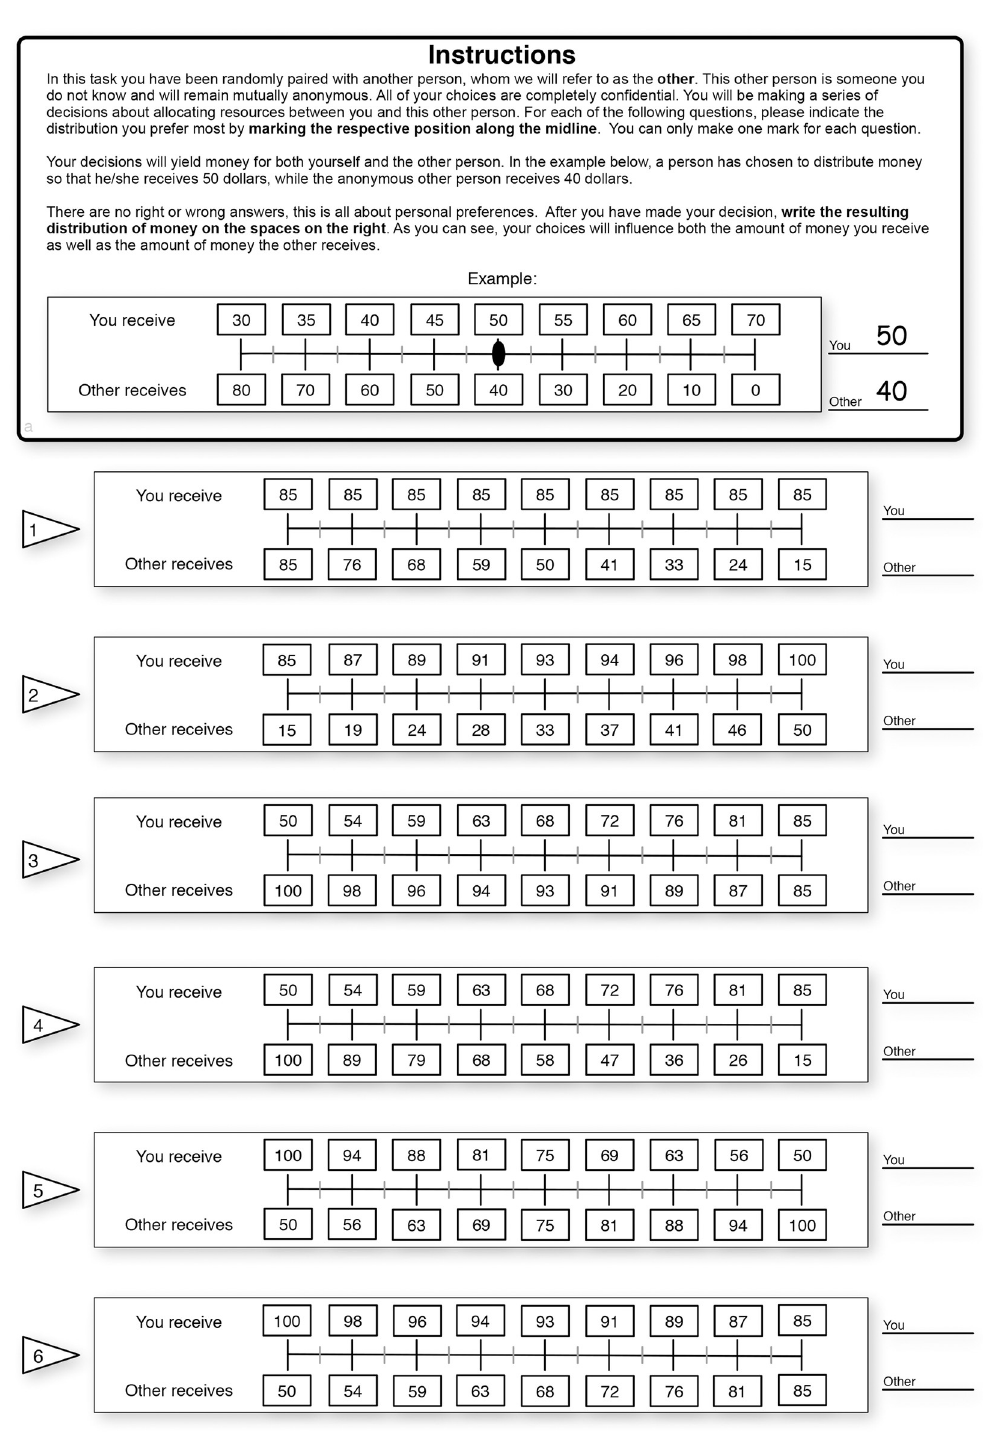
Fig 2. Instructions of SVO. Instructions of the “slider method” for measuring the social value orientation [92].